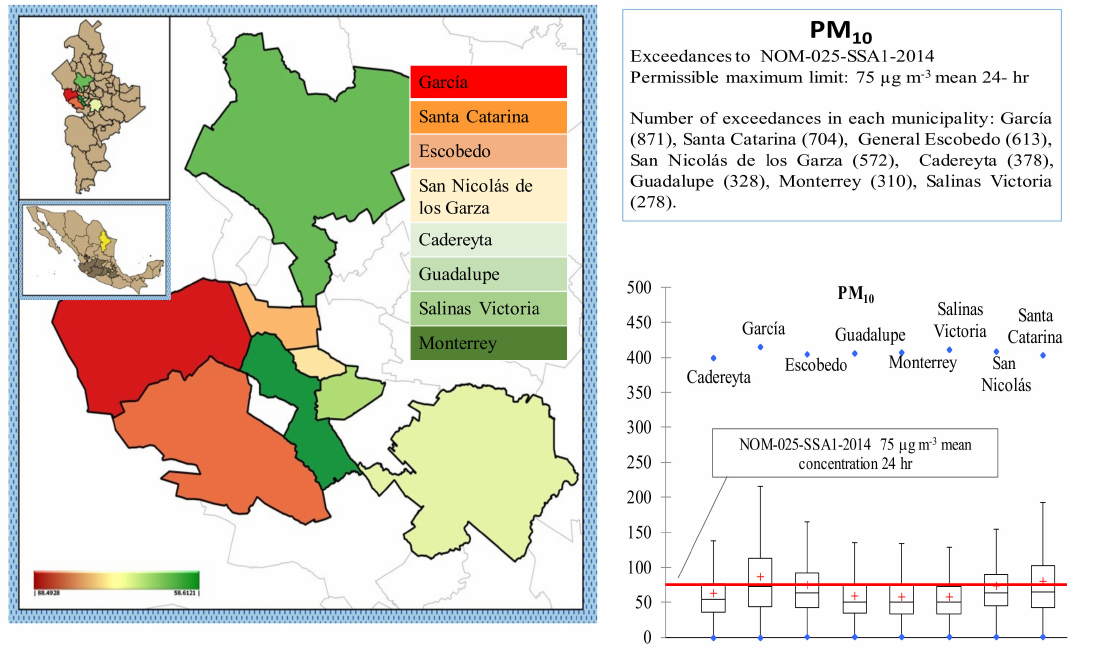
Figure 6. Mean concentrations of PM 10 in MAM during